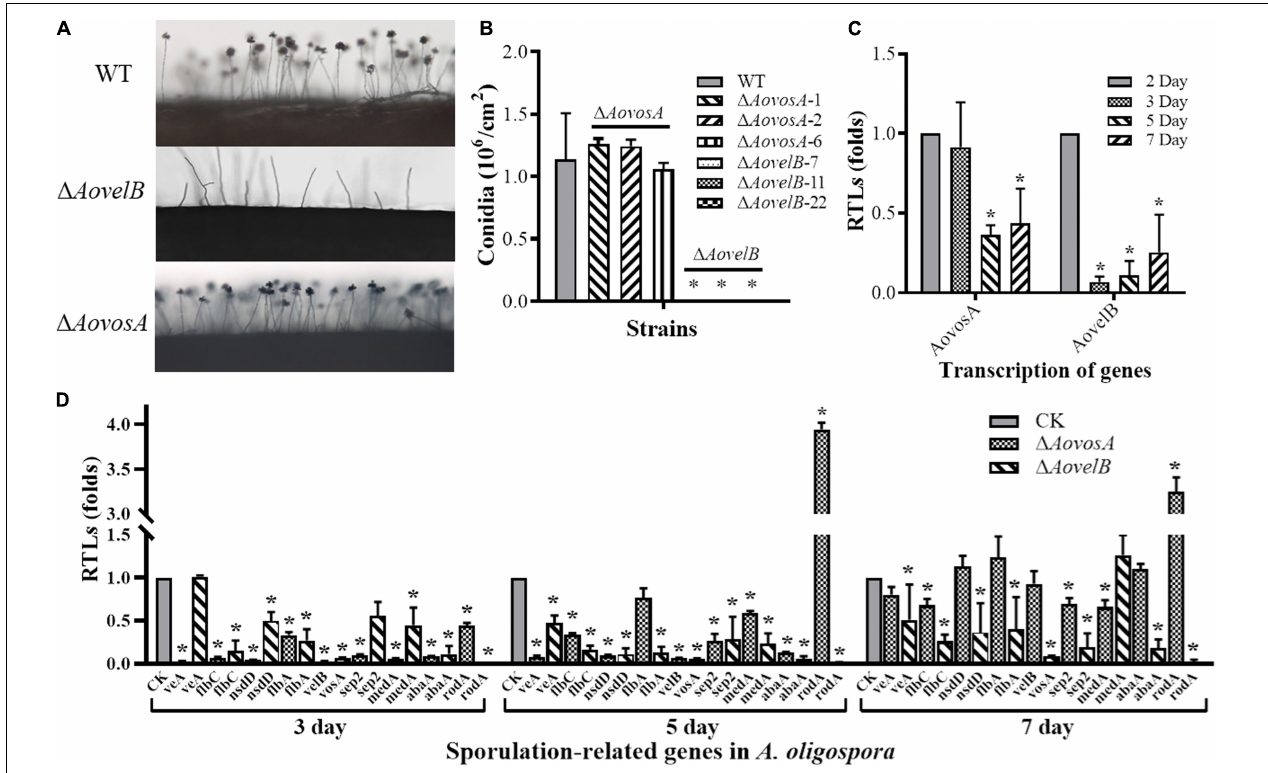
FIGURE 3 | Comparison of conidiation and the transcriptional levels of sporulation-related genes between the wild type (WT) and mutant lines. (A) Conidiophore differentiation in the WT and mutant lines. (B) Sporulation in the WT and mutant lines on CMY medium. (C) The relative transcriptional levels (RTLs) of genes AovosA and AovelB during the vegetative growth and conidiation in A. oligospora . (D) RTLs of sporulation-related genes in the mutants compared with the WT strain at different time points. CK. The level of each gene was computed as a ratio of the transcript level of the gene in the deletion mutant to that in the WT strain under a given condition. An asterisk indicates a significant difference between the mutants and the WT strain ( p <